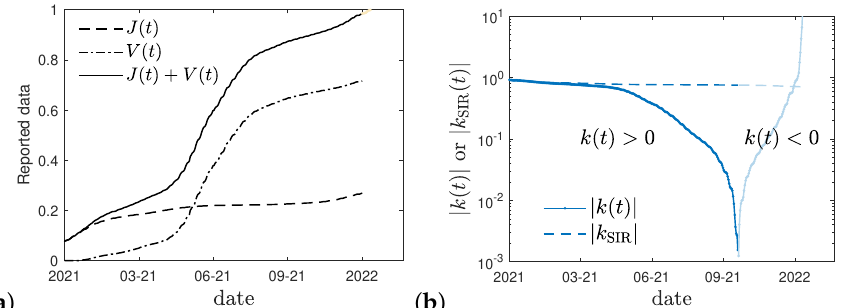
Figure 2. ( a ) Reported data [38] for Germany for the estimated cumulative fraction I ( t ) = 200 D ( t ) of infected people, where D ( t ) is the reported cumulative fraction of fatalities and V ( t ) is the cumulative fraction of vaccinated persons, as well as their sum. We assume here that vaccinated and infected fractions belong to disjunct compartments, the SIRV model therefore breaks down as soon as the reported I ( t ) + V ( t ) exceeds unity, manifested by a sign change of k ( t ) . ( b ) Ratios k ( t ) (solid) and k SIR ( t ) (dashed) according to Equation (24) with and without V ( t ) ,